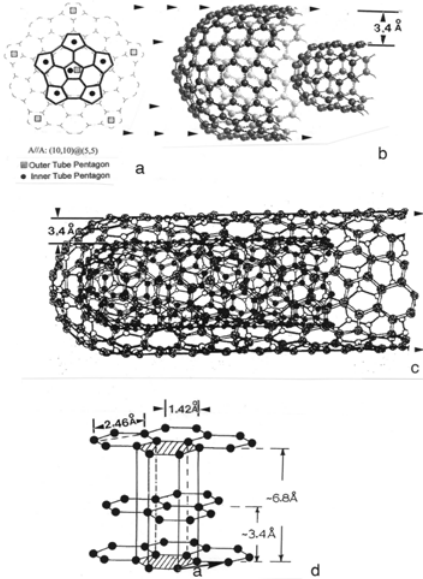
Figure 7: Carbon nanotube growth simulations and schematics. (a) Double cap nucleus. (b) Double tube nucleation and growth simulation from (a) forming an armchair tube growing over an armchair tube. ((a) and (b) are from Lair, et al. [44]. (c) Schematic showing a chiral tube growing over the same chiral tube. (d) Ideal graphite lattice and unit cell showing unit cell and graphene lattice dimensions.